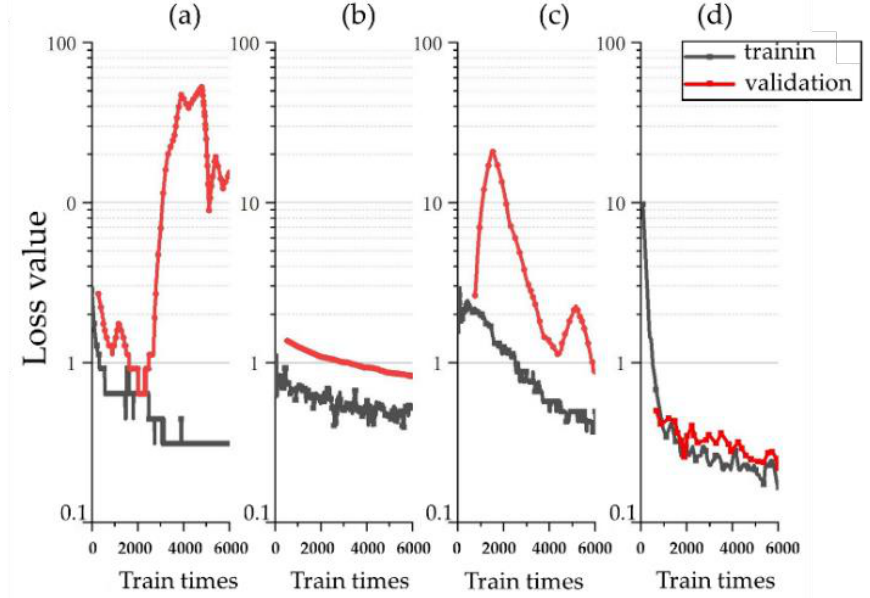
Figure 8. Loss value in the training and validation. ( a ) the training and validation loss using set A of Table 3. ( b ) the training and validation loss using set B. ( c ) the training and validation loss using set C. ( d ) the training and validation loss using set D.